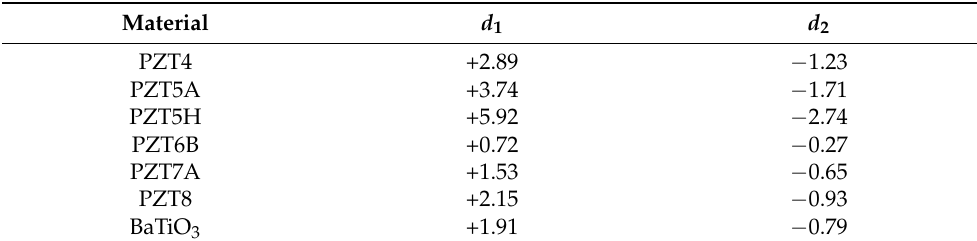
Table 2. Numerical values of the PZ coefficients d 1 and d 2 ( × 10 − 10 ) associated to different ceramic materials. Values are extracted from Ref.